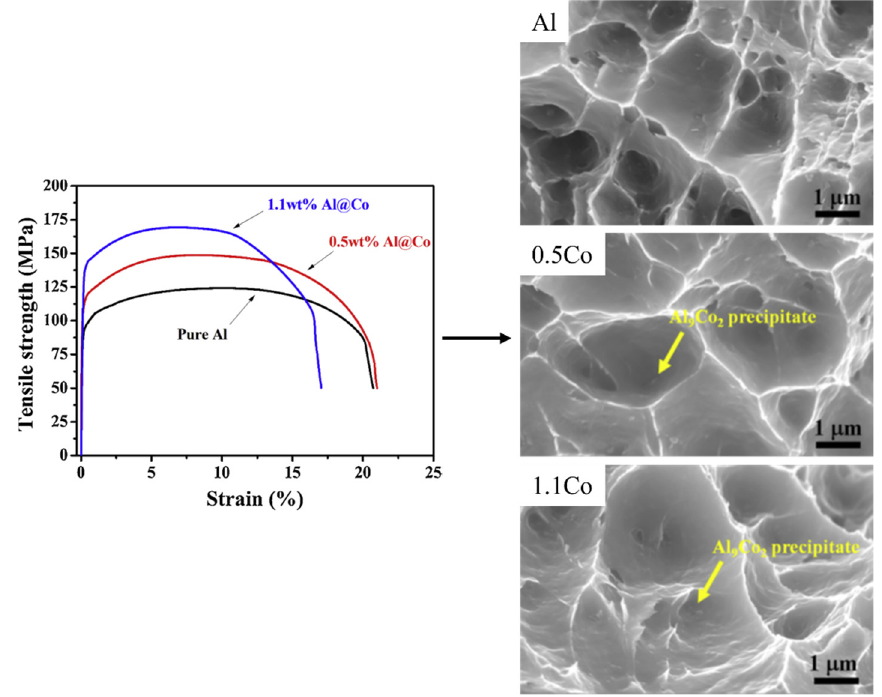
Figure 4. Tensile testing curves for Al, Al-0.5 wt % Co and Al-1.1 wt % Co fabricated by additive manufacturing and associated images of the fractured surface of tensile bars under SEM (Reprinted with permission from [37], Copyright 2022, Elsevier).